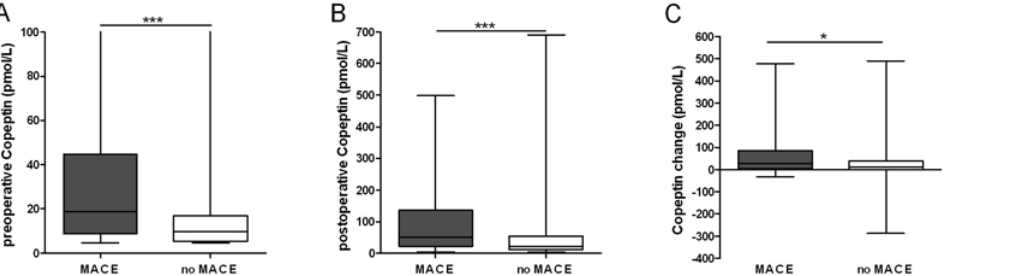
Association of Copeptin and postoperative high sensitive Troponin T Postoperative hs-cTnT levels ranged from < 3.0 to 1499.0 ng/L (median 13.8ng/L). The correla- tion between postoperative hs-cTnT and postoperative Copeptin was weak and likely not clini- cally relevant (r = .170, P = .001).